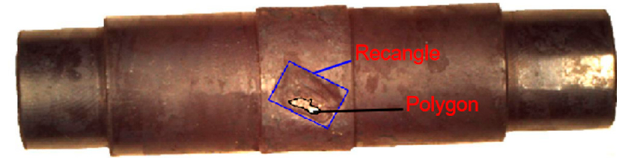
Figure 10. Identification of defect area in original image.